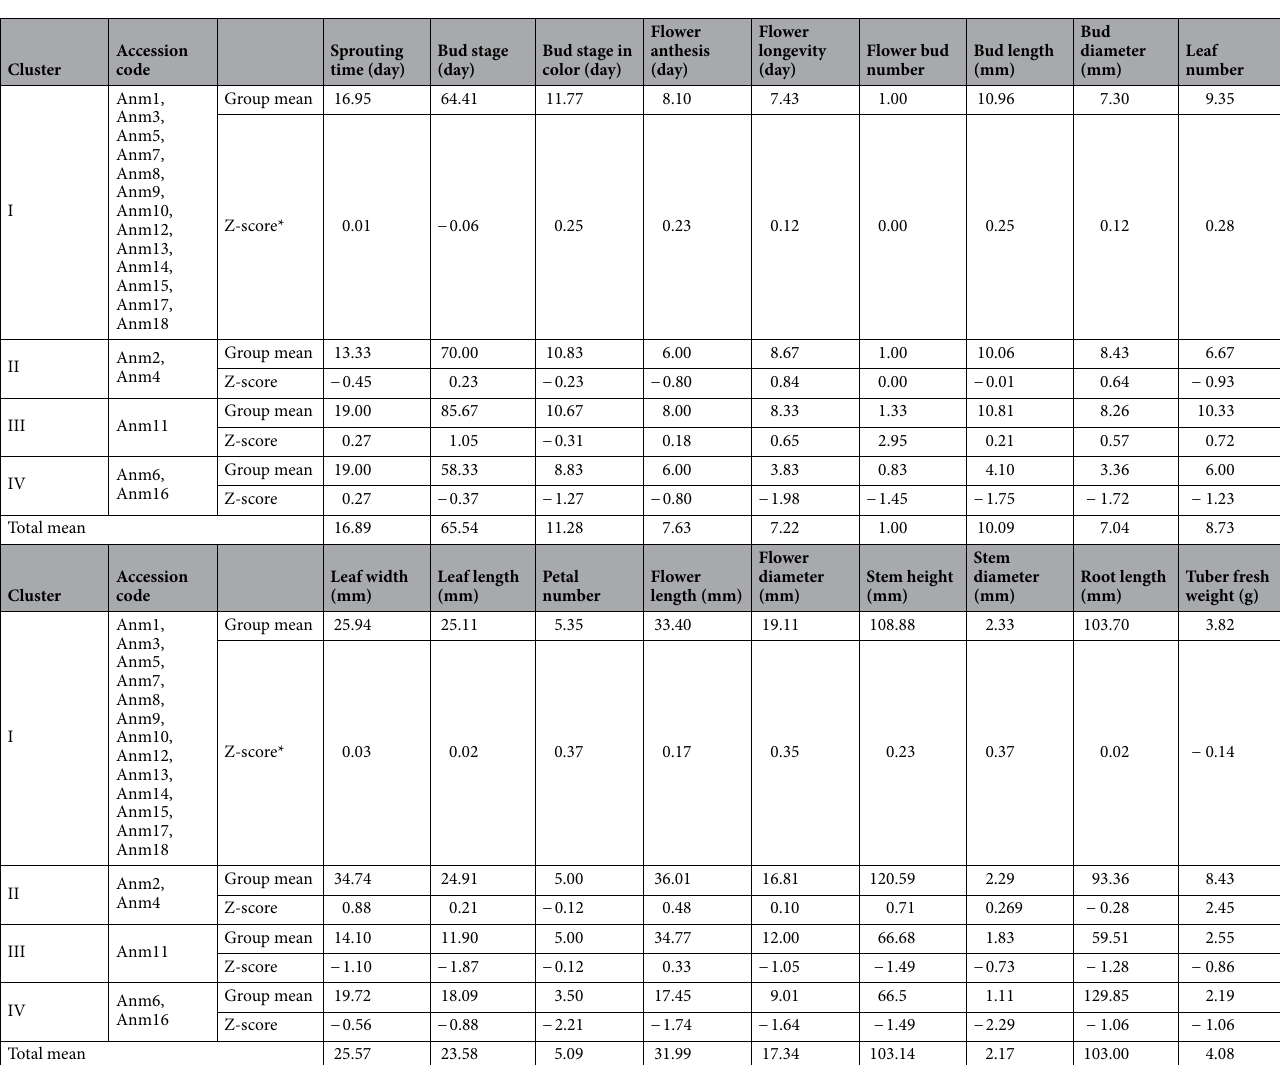
Table 7. Composition of the groups and the distribution of the Anemone accessions in each group based on cluster analysis under 5-azaC pre-treatment. *: Z-score was calculated as the difference between the mean of the trait (for each group) and the total mean, divided by the total standard deviation (SD). The highest positive Z-scores are associated with the relative highest value of the variable among the groups. Since the decrease in the value of phenological traits (except for flower longevity on plant) is a desirable feature, the groups with further negative Z-scores were considered to be more superior. Conversely, since the increase in the value of morphological traits is a desirable feature, the groups with further positive Z-scores were considered to be superior.